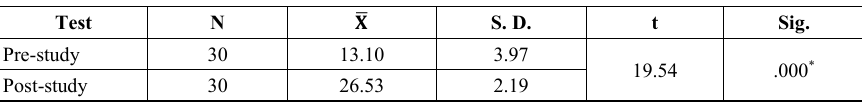
Table 5. Comparison of learner s’ learning achievement concerning pre-post study Level 1 – Digital Collaboration